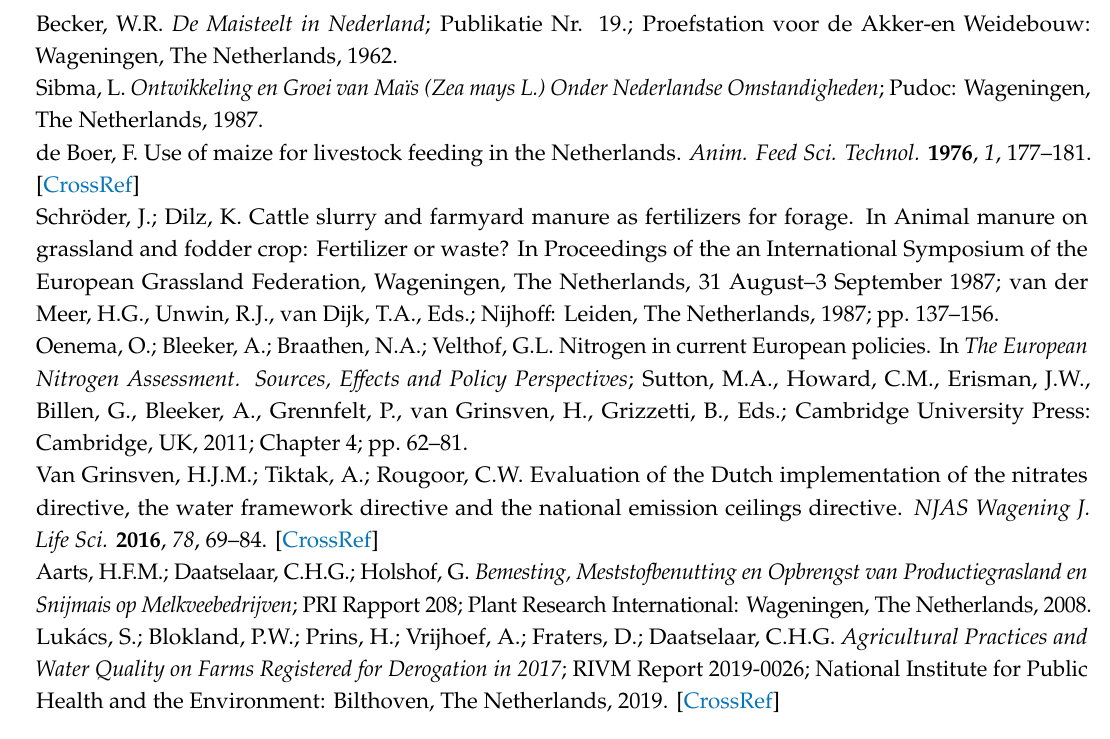
Table S1. Data used for the calculations of inputs and outputs of silage maize cultivation on sandy soils vulnerable for NO 3 leaching; Table S2. Emission factors used for the calculations of inputs and outputs of silage maize cultivation on dry sandy soils; Table S3. Results of the calculations of N and P yields, surpluses, use e ffi ciencies, and NH 3 , N 2 O, and NO emissions for silage maize cultivation on dry sandy soils for a farm with derogation (from 2006) and use of cattle